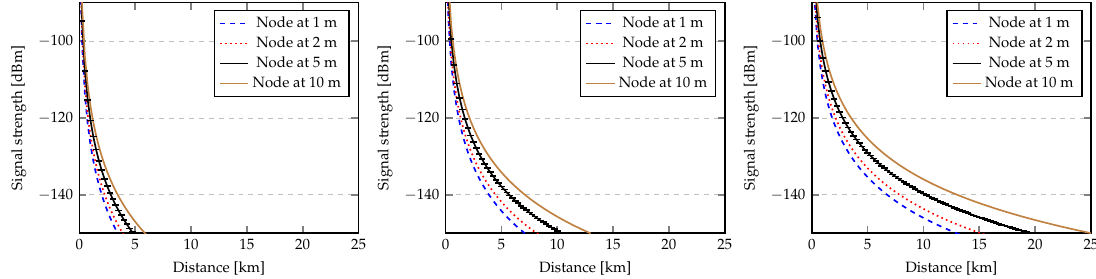
Figure 3. Evolution of R Pow taking into account different distances between gateway and node. Table 1. Maximum communication distance for different node heights. Node Height in Relation to Maximum Distance [m] Water Surface [m] 0.3 1250 1 1450 2